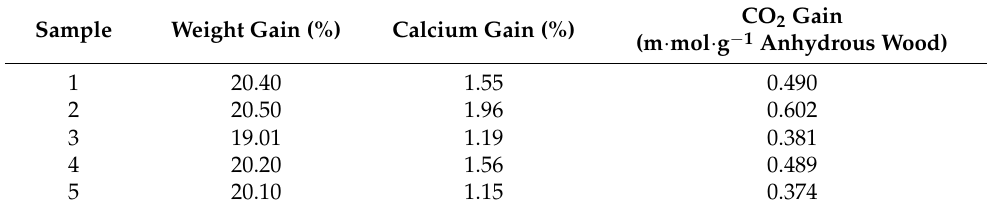
Table 1. Gains of weight, calcium, and carbon dioxide in mineralized samples.